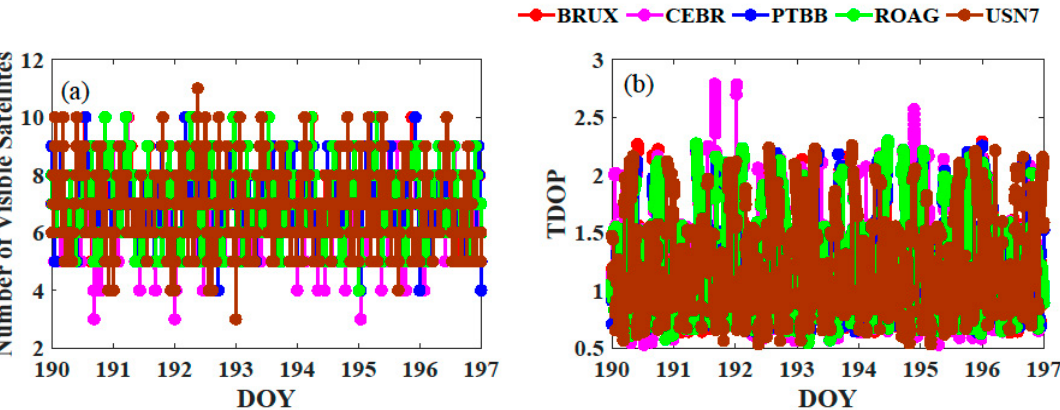
Figure 3. Number of visible satellites and time dilution of precision (TDOP) values at BRUX and PTBB for Galileo on DOYs 190 to 196 in 2020. ( a ) Number of visible satellites; and ( b ) TDOP values.